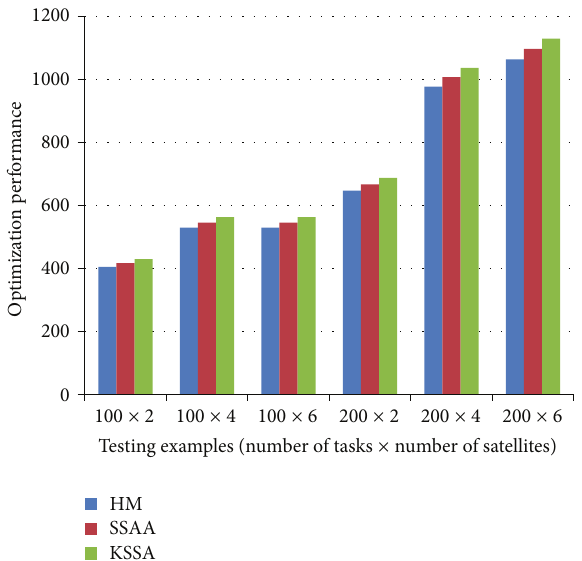
Figure 3: Experimental results in optimization performance of small scale testing